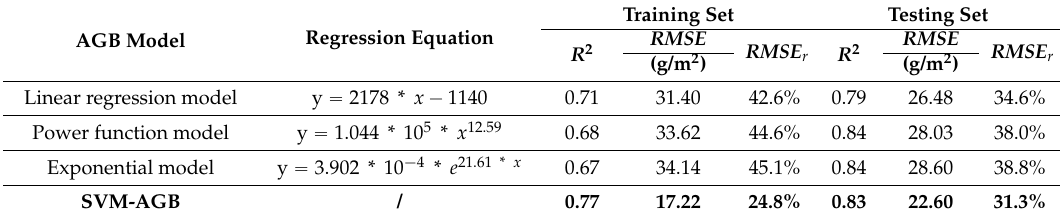
Table 5. Comparison of the accuracy of different AGB estimation models based on synthetic NDVI data.